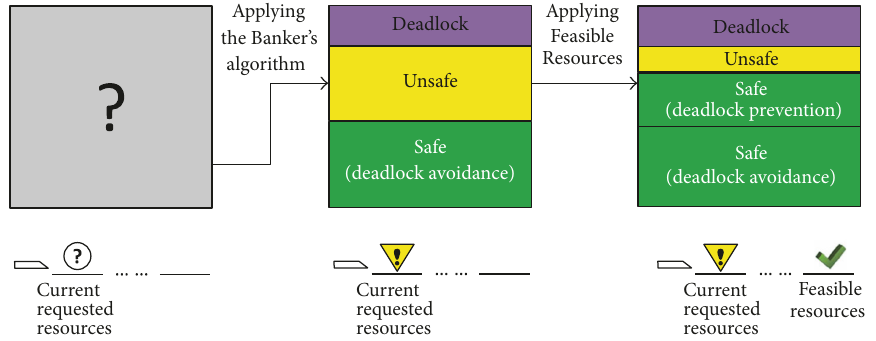
Figure 6: Searching feasible resources to reduce false-positive situations with the Banker’s algorithm [15].